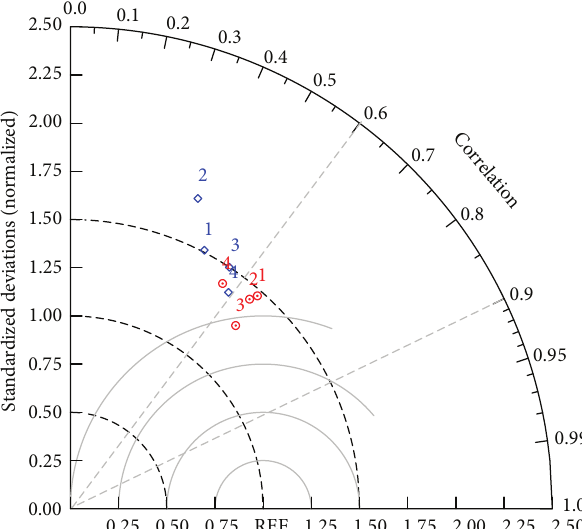
Table 6: A synopsis of the WRF model configuration used by